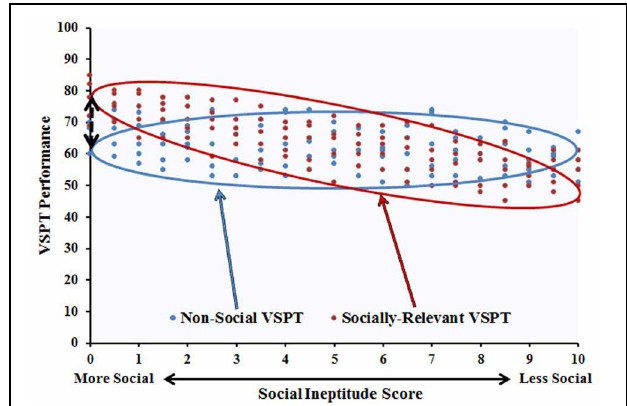
FIGURE 1 | Potential framework depicting the relationship between social skills and VSPT performance for proposed socially-relevant and non-social VSPT. The distinction between these two types of tasks is captured by the degree to which VSPT is incurring a social skill influence indexed by the magnitude of the